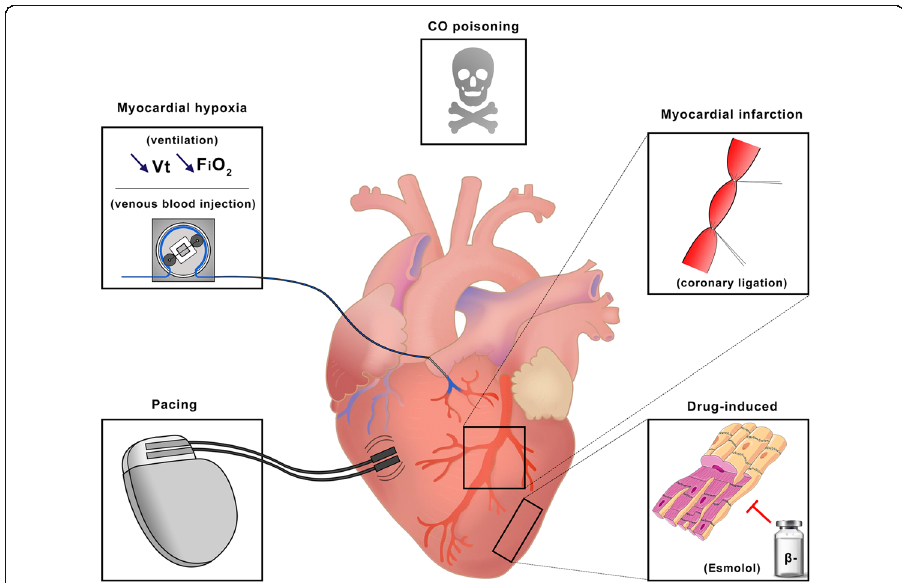
Fig. 2 Representation of the five heart failure models that were used in our review. From left to right: ventricular pacing, myocardial hypoxia (through lowering of mechanical ventilation or perfusion of desaturated blood in the coronary arteries), CO poisoning, myocardial infarction, and drug-induced heart failure. CO, carbon monoxide; FiO2, inspired fraction of oxygen; Vt, tidal volume. Images were obtained from https://smart.servier.com and are available under a creative commons